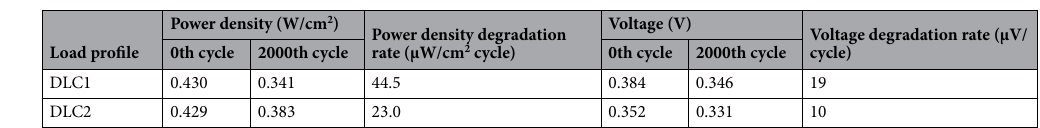
Table 4. Performance degradation of fuel cell operated under dynamic load